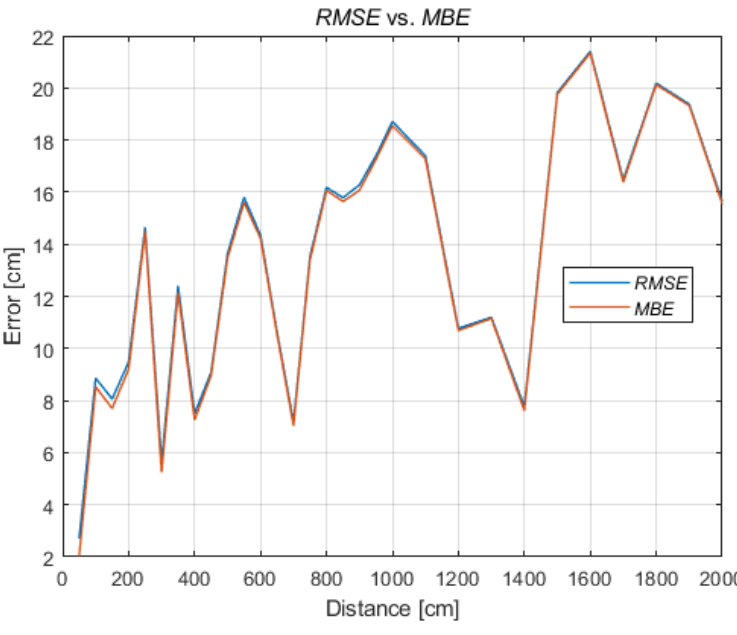
Figure 8. RMSE and MBE Figure 8. 𝑅𝑀𝑆𝐸 and 𝑀𝐵𝐸 .